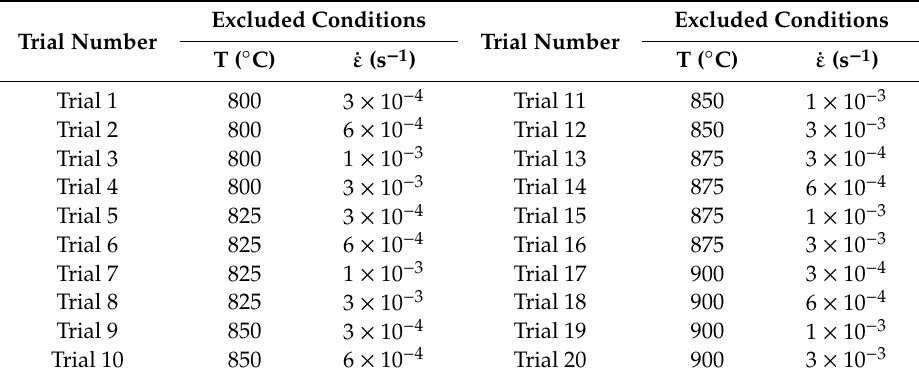
Table 4. The excluded conditions in trial datasets.